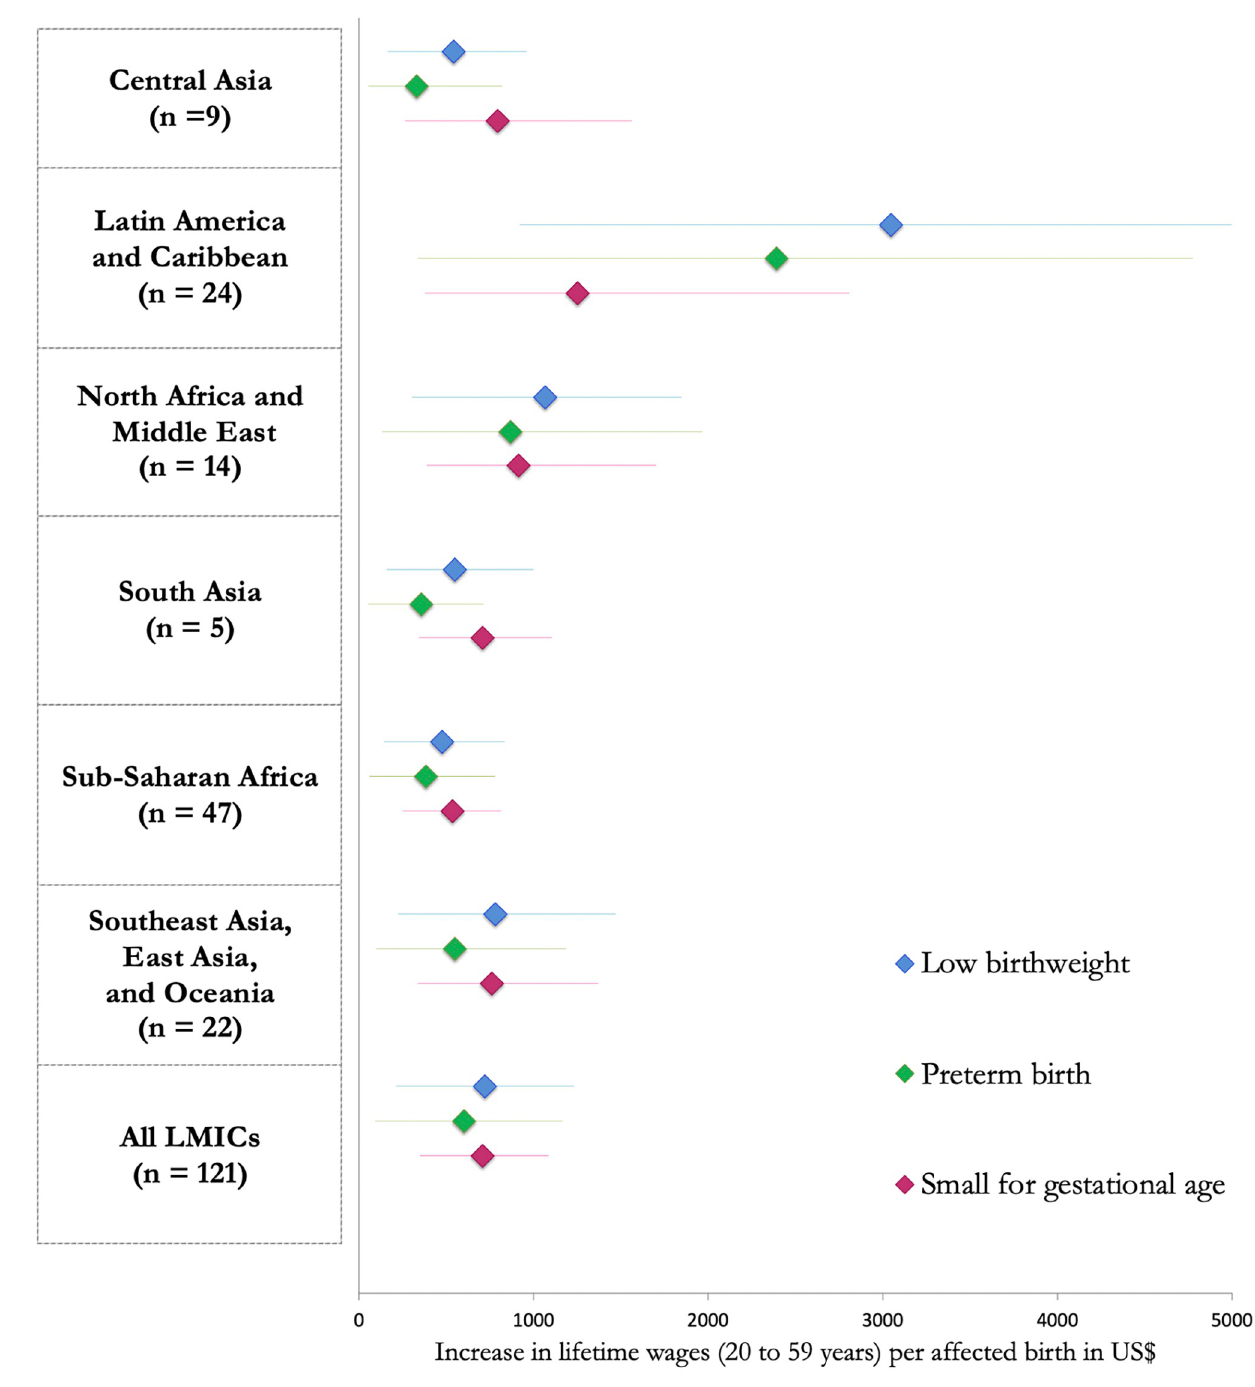
Fig 3. Gains in lifetime income per child born low birthweight, preterm, or small-for-gestational age in US$, by region. Maps were made using the spData package in R.